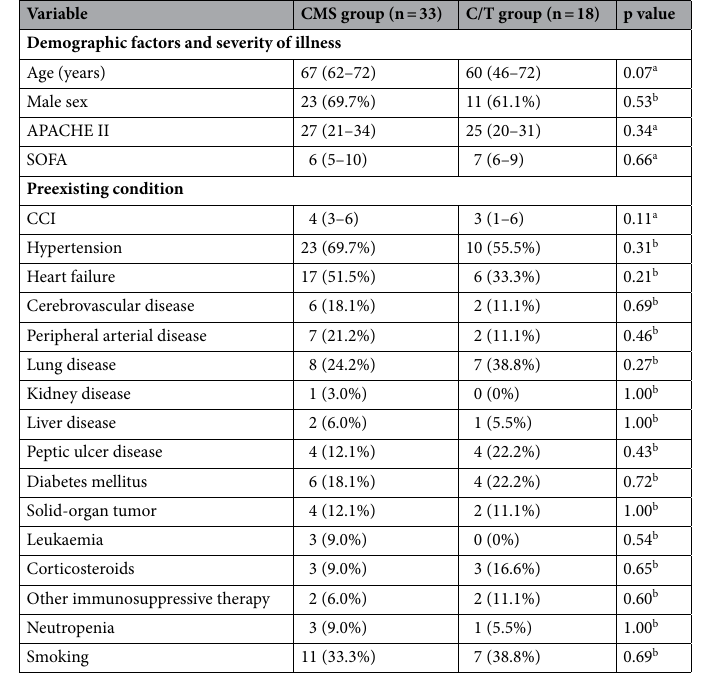
Table 2. Demographics and comorbidities in colistin and ceftolozane/tazobactam treated patient groups. APACHE II Acute Physiology and Chronic Health Evaluation II score, CCI Charlson Comorbidity Index, CMS colistimethate sodium, C/T ceftolozane/tazobactam, SOFA Sequential Organ Failure Assessment score. a Mann–Whitney U test. b χ 2 test or Fisher’s exact test.